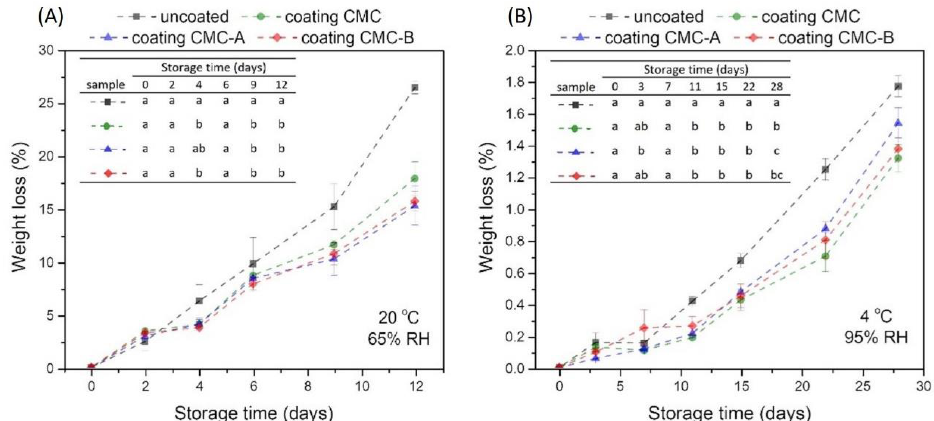
Figure 2. Weight loss of the coated and uncoated fresh goldenberries during storage at 20 °C and 65% RH ( A ) and 4 °C and 95% RH ( B ). Results are expressed as mean ± standard deviation ( n = 3). In the inserted table, different letters on the same analysis day correspond to statistically different values for a 95% confidence level.